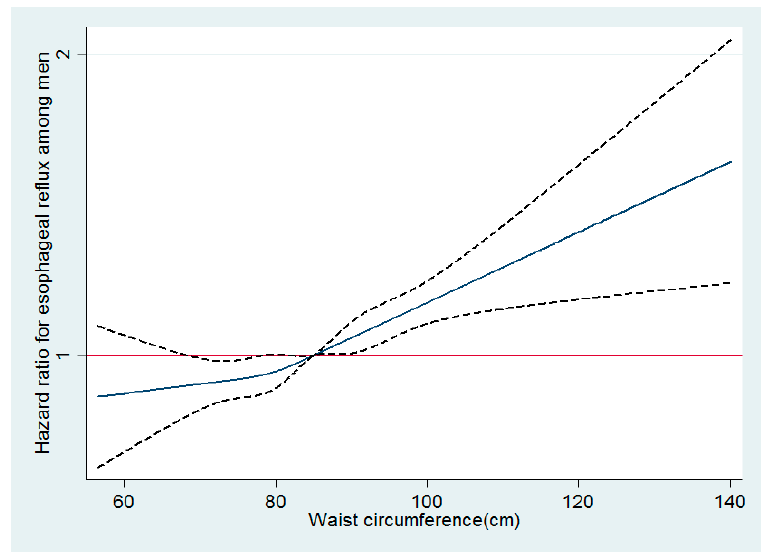
Figure 1. Multivariable-adjusted hazard ratios for reflux esophagitis by waist circumference among men. Curves represent adjusted hazard ratios for reflux esophagitis based on restricted cubic splines with knots at the 5th, 27.5th, 50th, 72.5th, and 95th percentiles of waist circumference. Models were adjusted for age, center, year of screening exam, smoking status, alcohol intake, physical activity, education level, history of diabetes, medication for diabetes, history of hypertension, medication for hypertension, and medication for dyslipidemia. The red solid line represents the reference plane; the navy solid line represents hazard ratio; and the black dotted lines represent 95% confidence intervals.